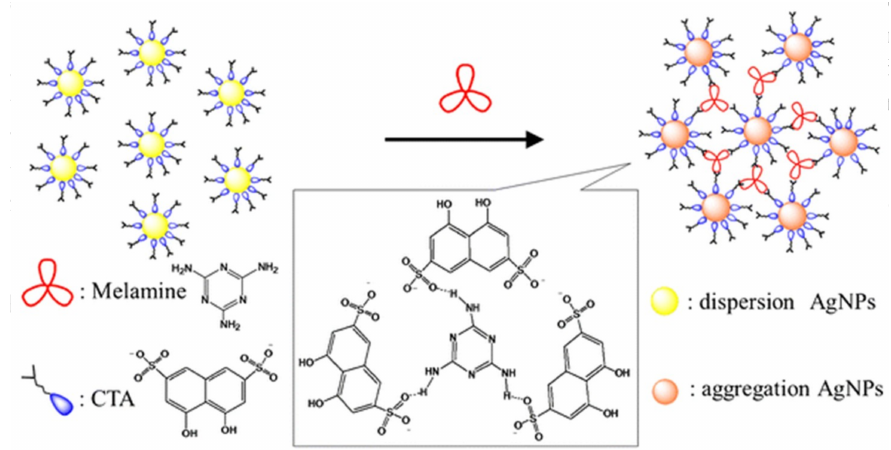
Figure 20. Schematic illustration of possible mechanism for sensing melamine based on CTA-AgNPs (reproduced with permission from Reference